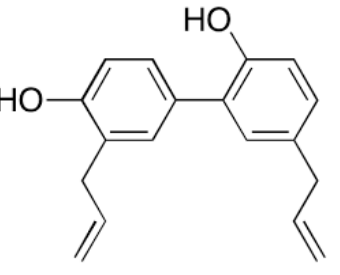
Figure 7. Honokiol: Biphenyl natural anti-cancer compound from Magnolia glandiflora.